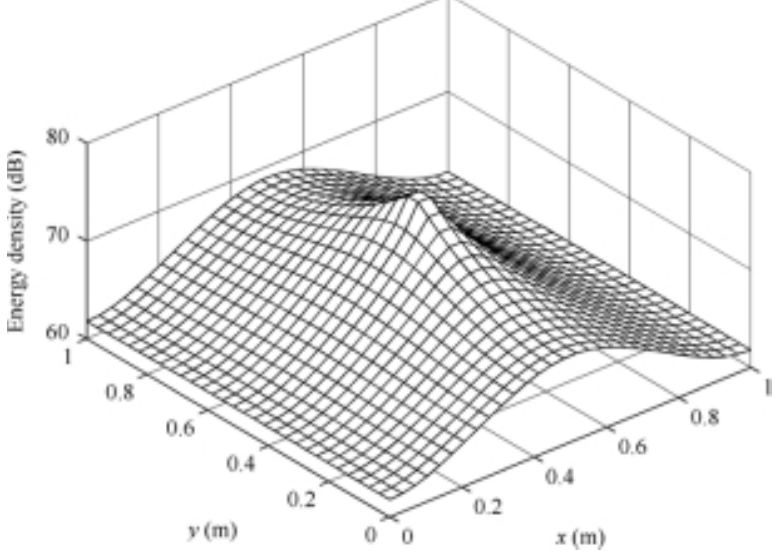
Fig. 20. The approximate energy density distribution of the orthotropic plate when f = 1 kHz and η = 0 . 2 . The reference energy density is 1 × 10 − 12 J/m 2 .